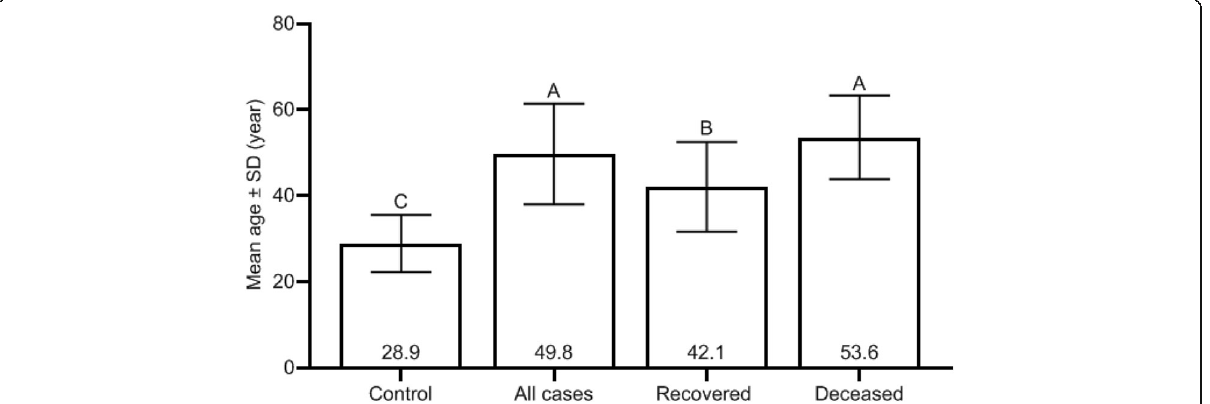
Fig. 2 Coronavirus disease 2019 cases and control distributed according to mean age. Different uppercase letters represent significant difference between means of bars ( p value < 0.001), while similar letters represent no significant difference between means of bars ( p value > 0.05) (Duncan multiple range